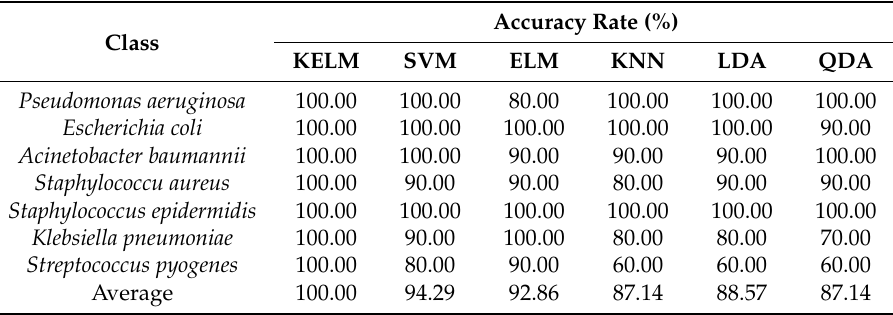
Table 7. Accuracy results of various feature extraction techniques and classification models for datasets in